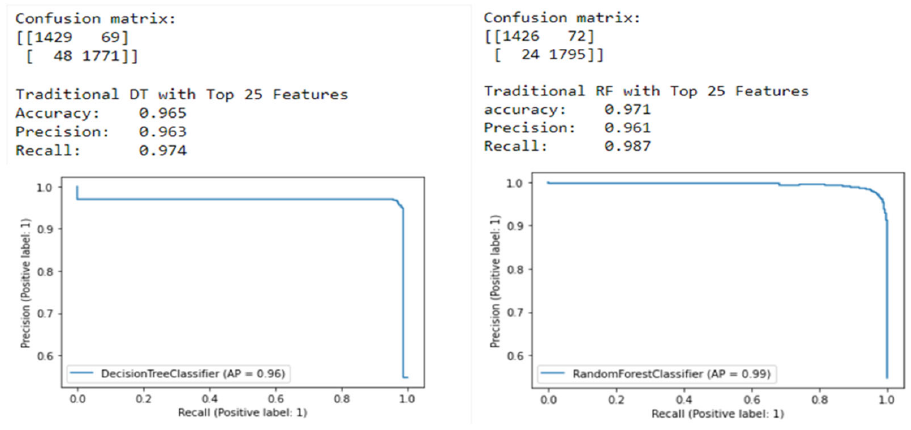
Fig. 12. The traditional classification with the top twenty-five features yields results.